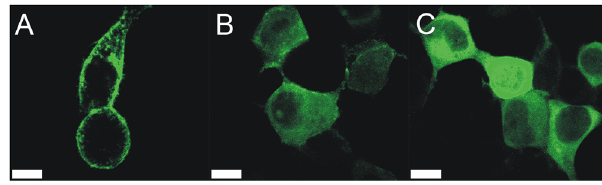
Fig. 5 Mimicking acetylation inhibits EHD2 distribution to the plasma membrane, yielding a diffuse cytoplasmic distribution. A – C Fluorescent confocal microscopy of HeLa cells expressing GFP-EHD2-WT ( A ), GFP- EHD2-K324Q ( B ) or GFP-EHD2-324Q328Q ( C ). Scale bars: white bar